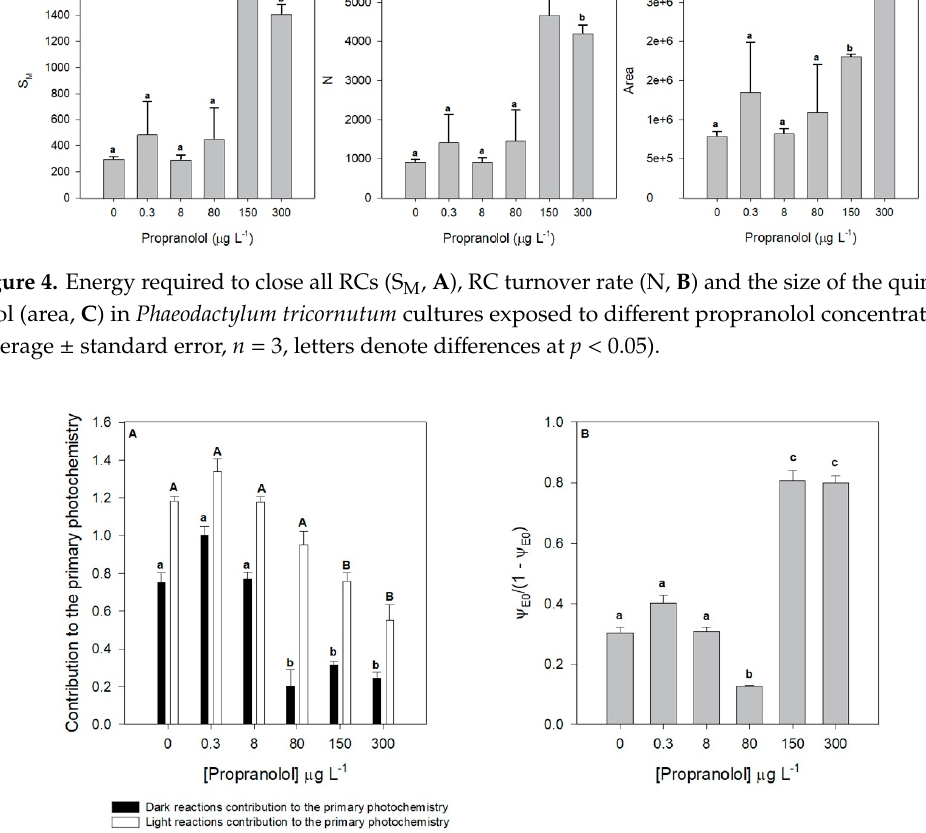
Figure 5. Contribution of the light and dark reactions to the primary photochemistry ( A ) and redox equilibrium constant between photosystem I and II ( B ) in Phaeodactylum tricornutum cultures exposed to different propranolol concentrations (average ± standard error, n = 3, letters denote differences at p <